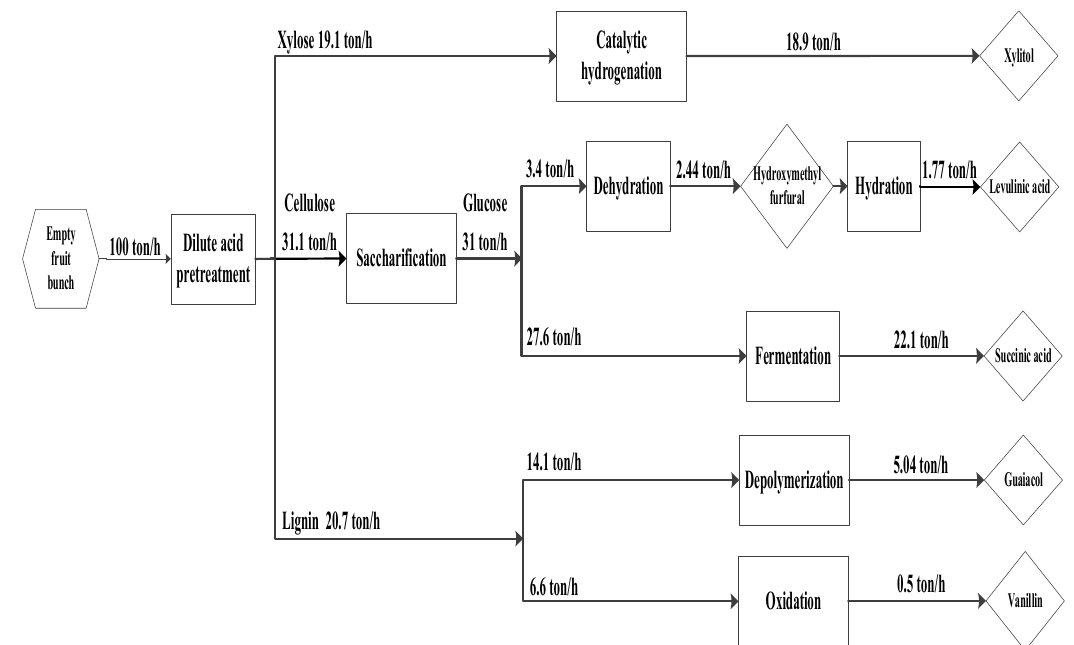
Figure 6. The biorefinery configuration of the optimal point S1 for profit and global warming potential objectives.